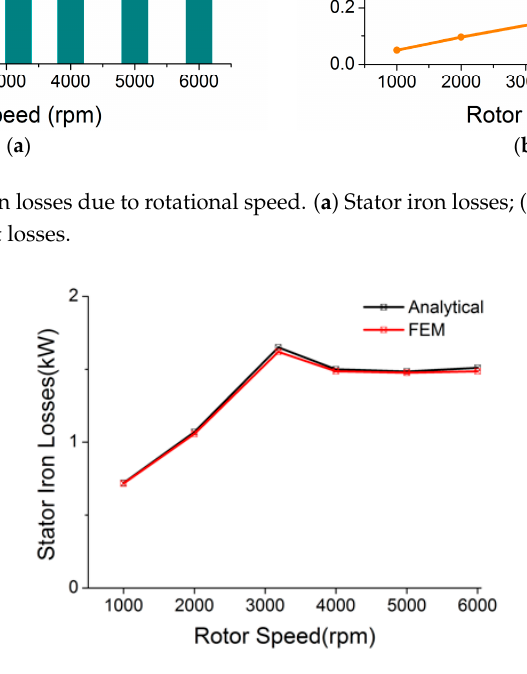
Figure 10. Stator iron losses of different rotational speeds (1000, 2000, 3185, 4000, 5000, and 6000